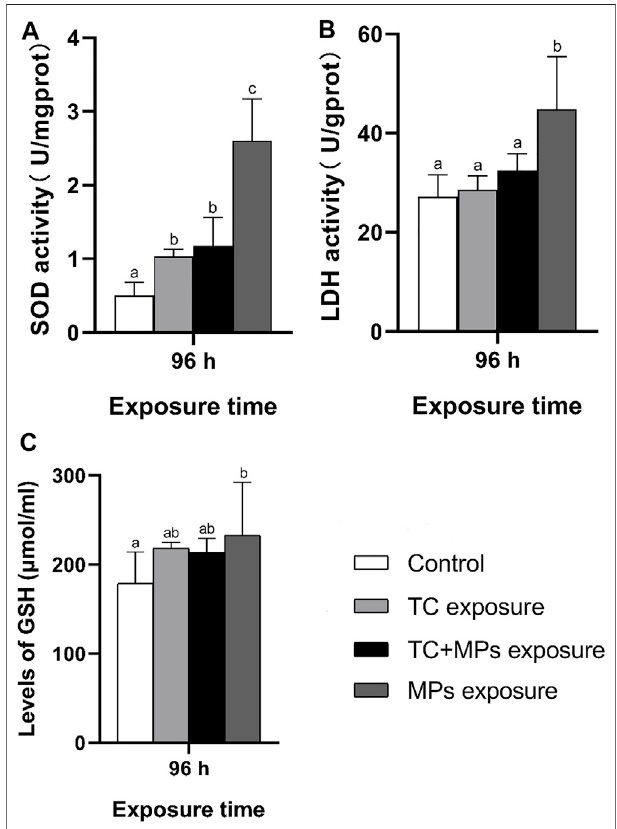
FIGURE 2 | Biochemical responses in intestines of Jian carp exposure for 96 h toTC and MPs. Key: (A) SOD activity; (B) LDH activity; (C) GSH level. The values represent mean ± SD of three independent experiments. Different lowercase letters indicate statistically signi fi cant difference between treatments ( p <